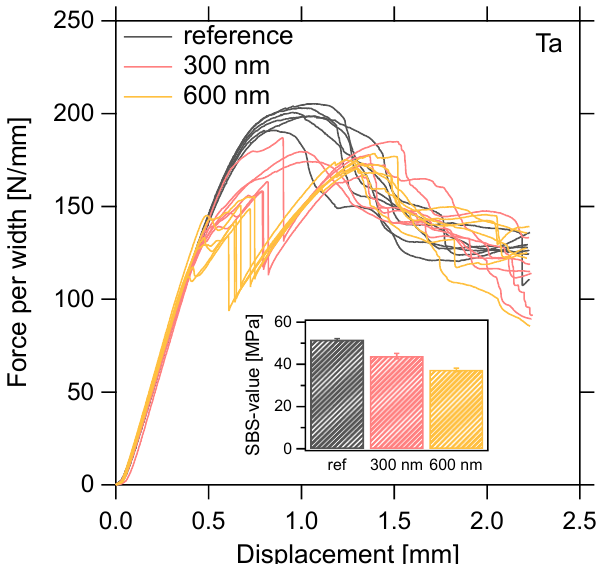
Figure 2. Overview of the load displacement curves of the short beam shear test for laminates produced by VARTM with different conditions for the midplane fiber mat:untreated reference, fully coated by a 300 nm tantalum film, fully coated by a 600 nm tantalum film. Each sample was tested at least four times. The error on these measurement is small as can be evaluated from the small error